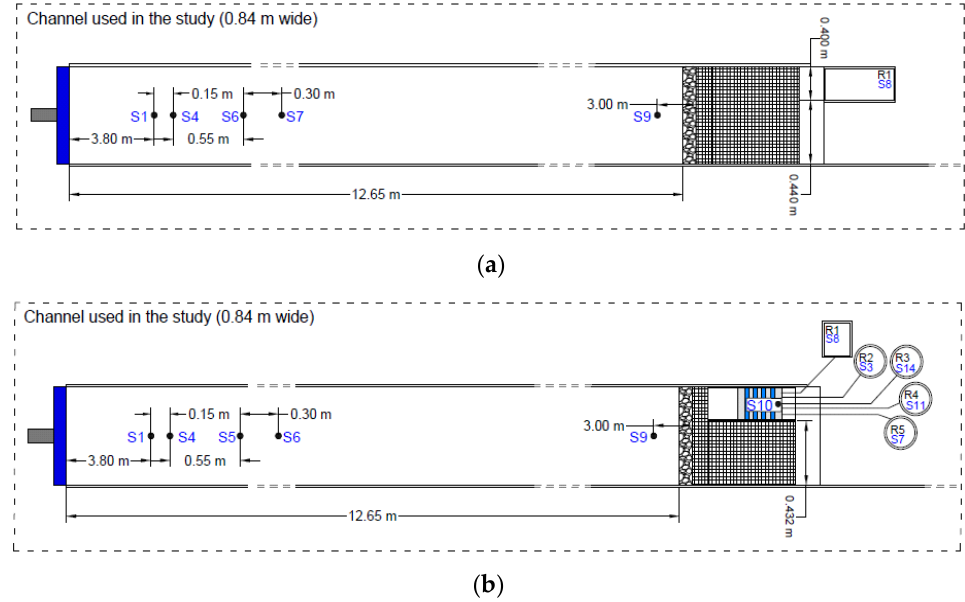
Figure 5. Experimental setup: ( a ) initial case, without WEC; ( b ) case with integrated WEC. For the extreme wave tests, which are the scope of this paper, only reservoir R1 was active.